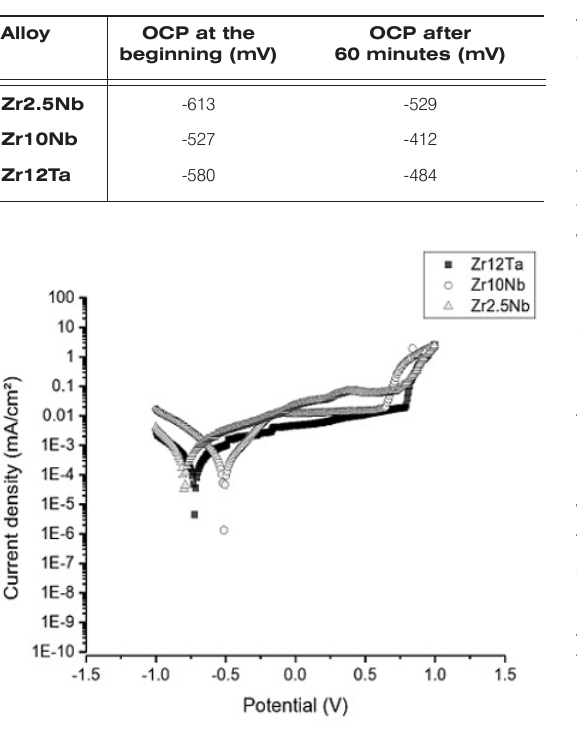
Table 5. Open circuit potential measurements.